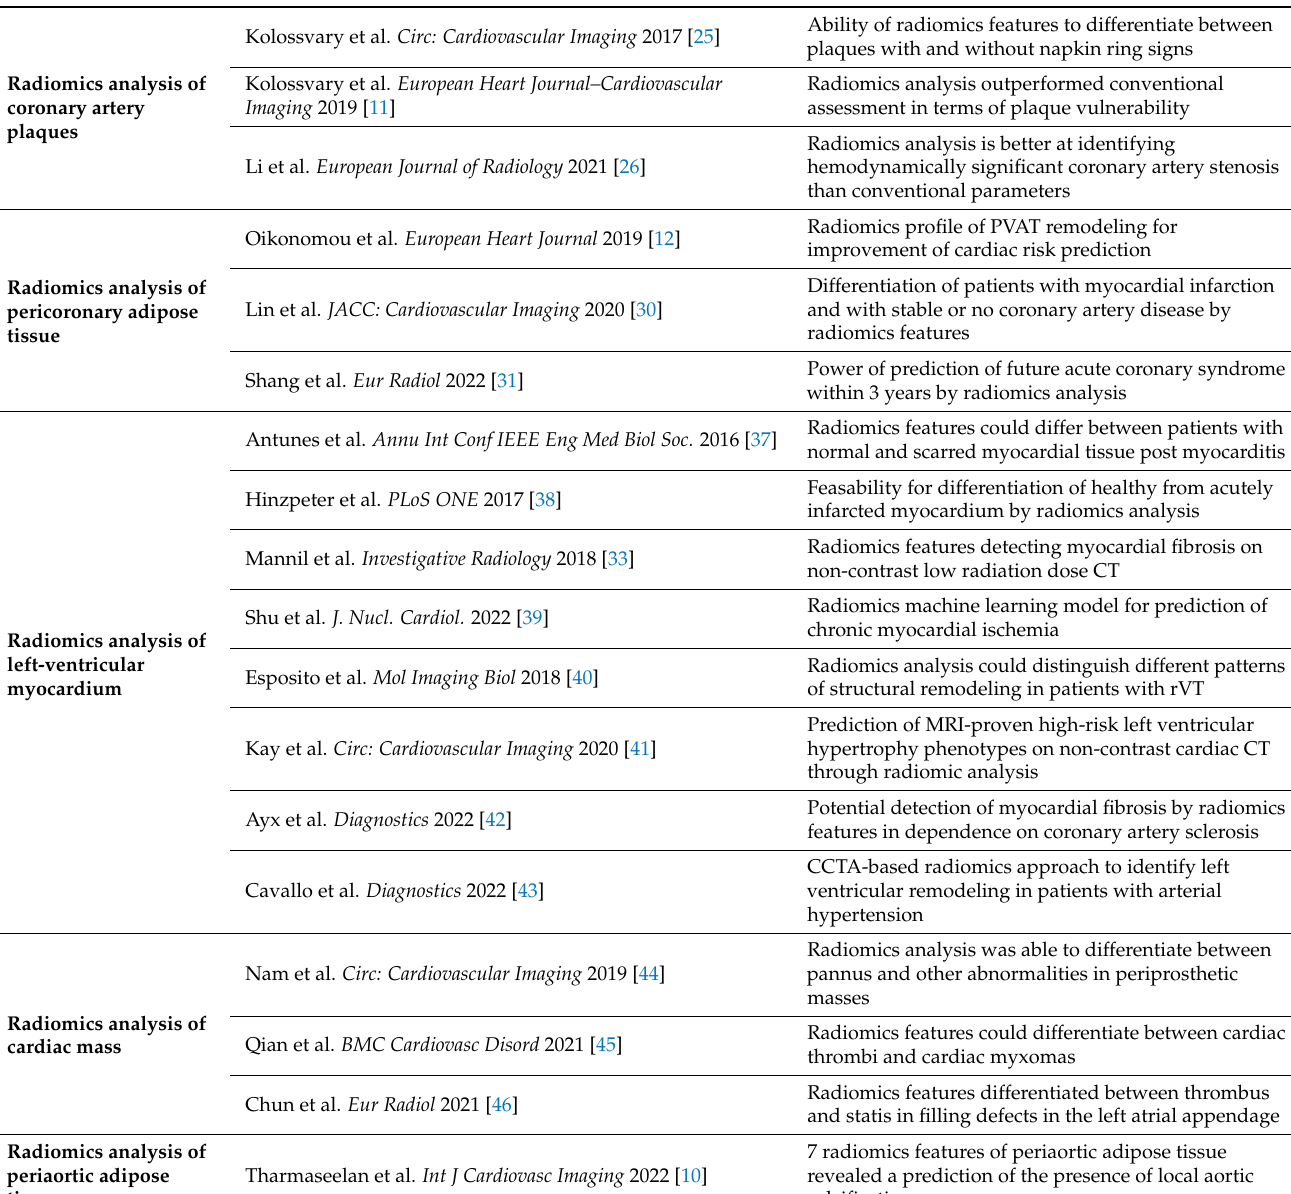
Table 1. Overview of radiomics analysis in cardiac